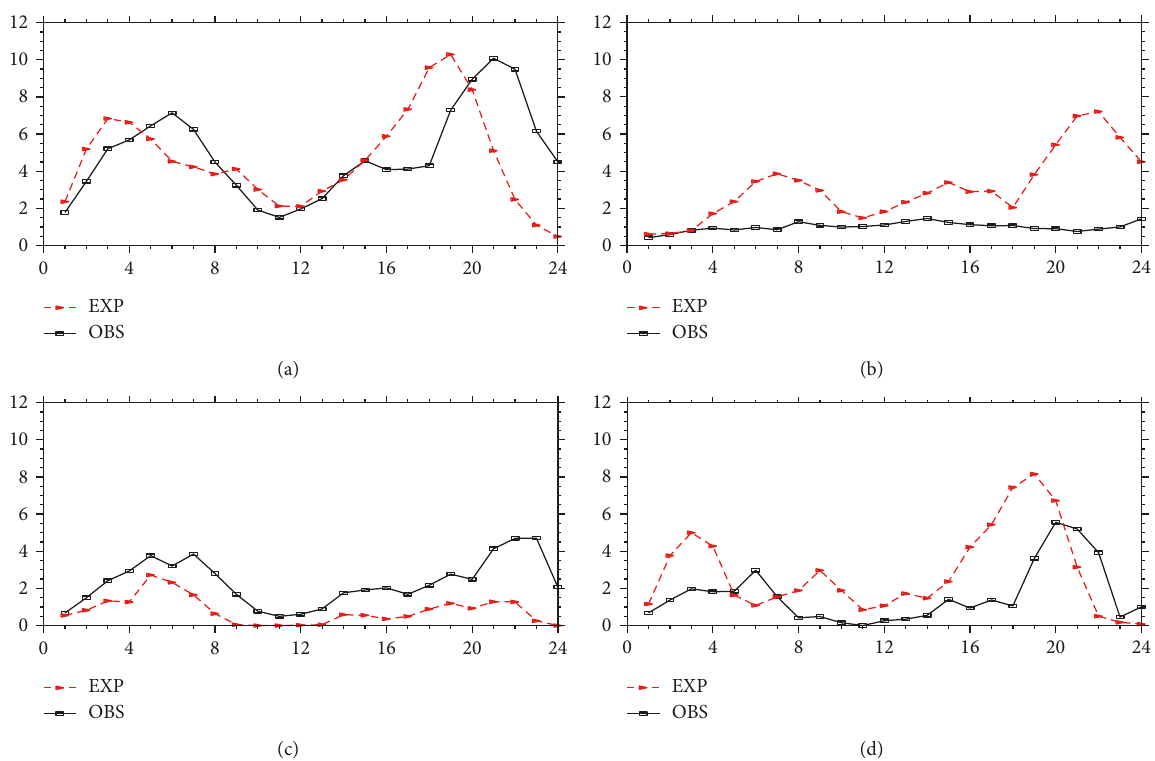
Figure 3: (a) Time series of hourly average precipitation over the key rainstorm area from observations (black solid line) and simulations (red dashed line) (unit: mm h ·